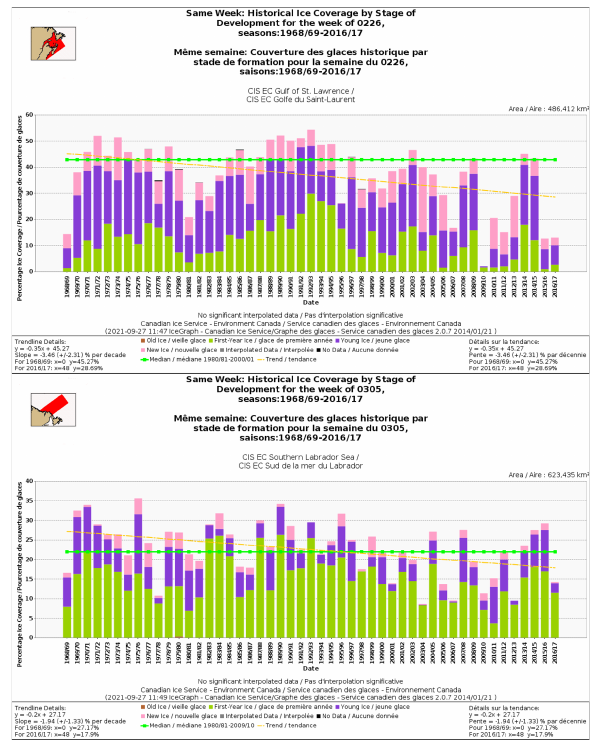
Figure 2. Historic ice cover (1969-2017), by type, in the southern Gulf of St. Lawrence (top, week of February 26), and off southern Labrador (bottom, week of March 3). Harp Seals prefer first year